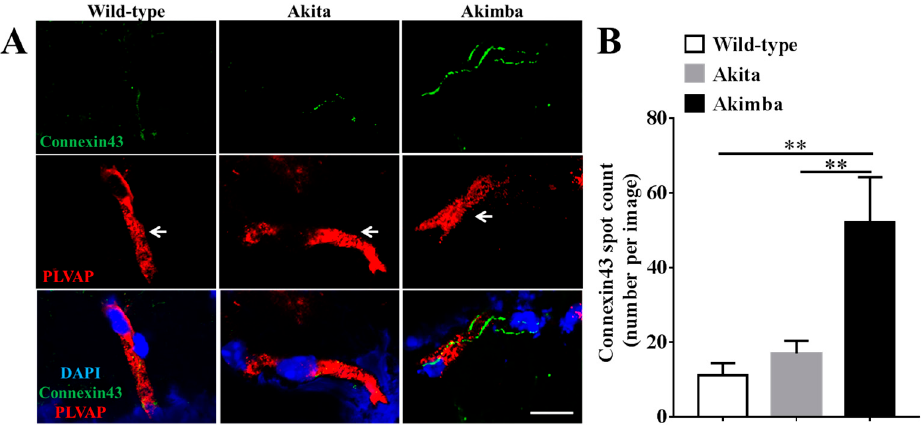
Figure 5. Connexin43 expression in PLVAP-positive blood vessels in the IPL of wild-type, Akita, and Akimba retinas. ( A ) Connexin43 expression (green) in blood vessels (PLVAP, red) in the IPL of wild-type, Akita, and Akimba retinas. Blood vessels are indicated by white arrows. Scale bar: 10 µm; ( B ) quantification of the number of connexin43 spots per blood vessel in wild-type, Akita, and Akimba mice. There was no significant difference in the number of connexin43 spots in blood vessels of Akita compared to wild-type mice ( p > 0.9999). Akimba mice, however, showed a significantly higher connexin43 spot count compared to wild-type and Akita retinas ( p = 0.0011 for both). Data presented as mean + SEM. Statistical comparisons were carried out using one-way ANOVA with Tukey’s multiple comparisons test; n = 4 animals/group; ** p ≤ 0.01.